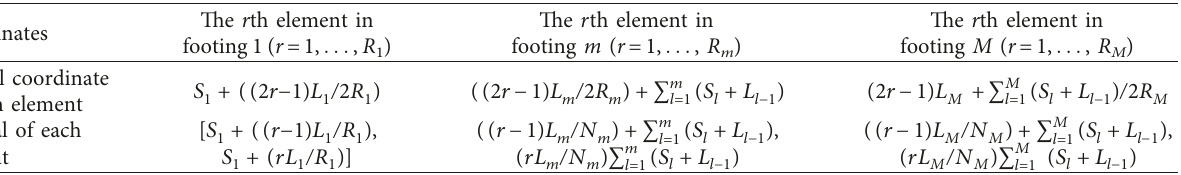
Table 1: Coordinate information of each element.